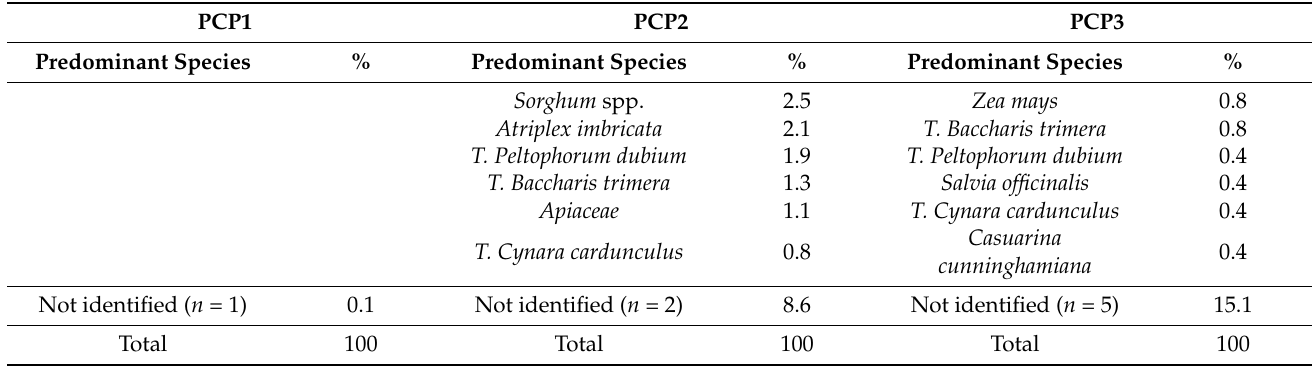
In the propolis extract (PE),the total polyphenols content in equivalence of pinocem- brin–galangin mixture was quantified by the Folin–Ciocalteu reaction, obtaining the follow- ing results: PCP1 51,530 ± 1 mgg − 1 ; PCP2 45,269 ± 4 mgg − 1 ; and PCP3 28,696 ± 2 mgg − 1 . The entire total flavonoids content (flavones and flavonols), quantified by AlCl 3 method- ology was: PCP1 19,331 ± 2 mgg − 1 ; PCP2 16,440 ± 4 mgg − 1 ; and PCP3 12,297 ± 5 mgg − 1 . The Angol sample exhibits significant statistical differences in comparison with the other samples, as shown in Figure 1.